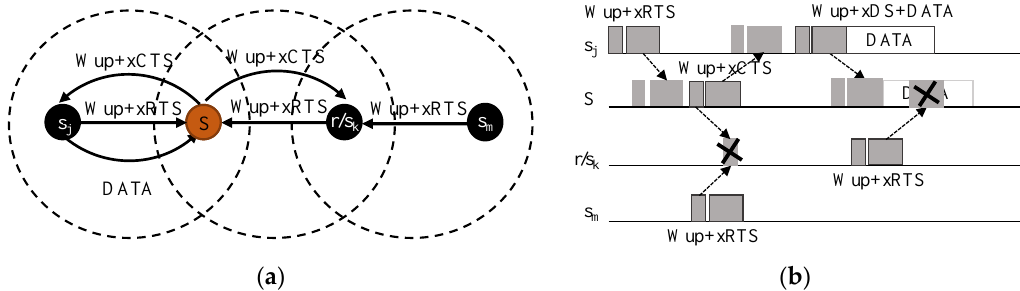
Figure 3. Handshaking multi-hop scenario adding asynchronous wake-up tones ( a ) and a conflicting example ( b ).